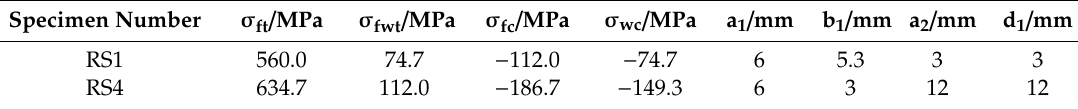
Table 6. Residual stress distribution pattern data of